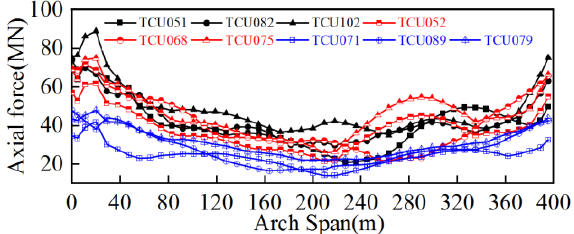
Figure 14. Axial force of arch rib in BRB- I scheme.